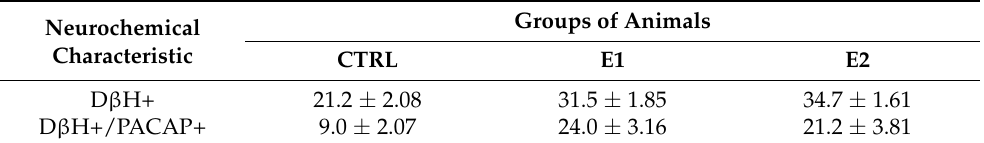
Table 2. Changes in the count of intrahepatic sympathetic nerve fibers as well as altered neurochemical characteristics after exposure to BPA under physiological conditions.